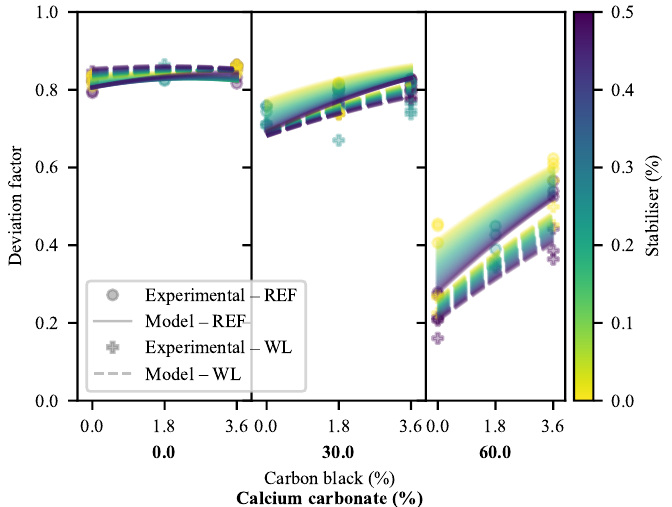
Figure 11. Influence of the loadings of calcium carbonate, carbon black and the stabiliser package on the DFs of the system, with fitted models. Note the sharper slopes of the REF cases and the switch-over from 0-CC to